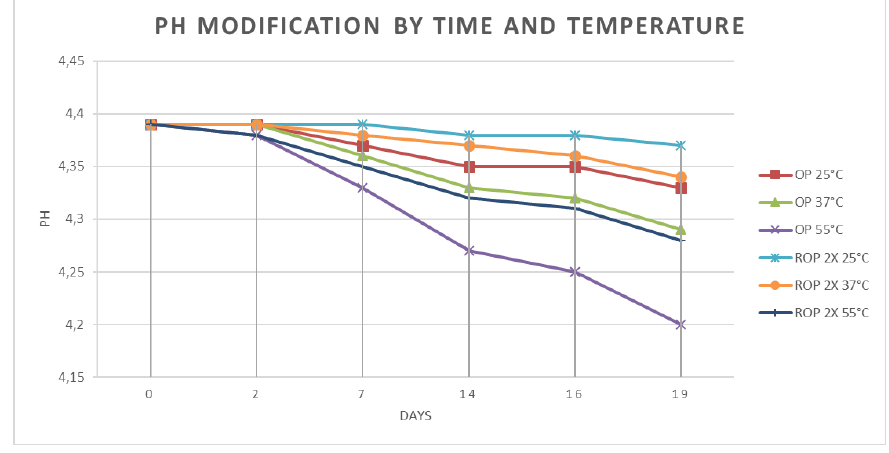
Figure 4. Results of the stress test for pH.